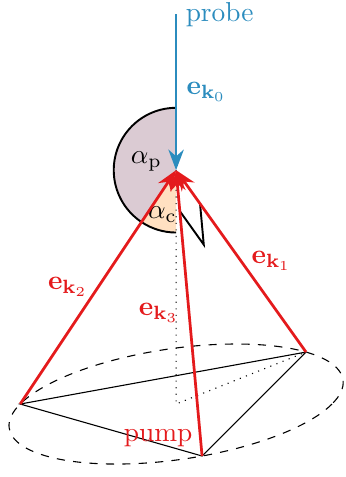
Figure 1. Illustration of the setup. The three red arrows represent the unit wave vectors e k ( i 1,2,3 ) i ∈ { } for the pump field. They form a right triangular pyramid where the isosceles are described by theses three unit wave vectors e k . The angle between them are 90 ◦ and the angle between these and the i distance perpendicular to the base is α c 54.74 ◦ . Besides, the blue arrow symbolizes the unit wave ≈ vector e k of the probe beam; it includes the angle α p 125.26 ◦ with each pump unit wave vector. 0 ≈ For the pump laser beams we choose the wave vectors k i = ν i ω 0 e k with i 1, 2, 3 , where the i ∈ { } unit wave vectors